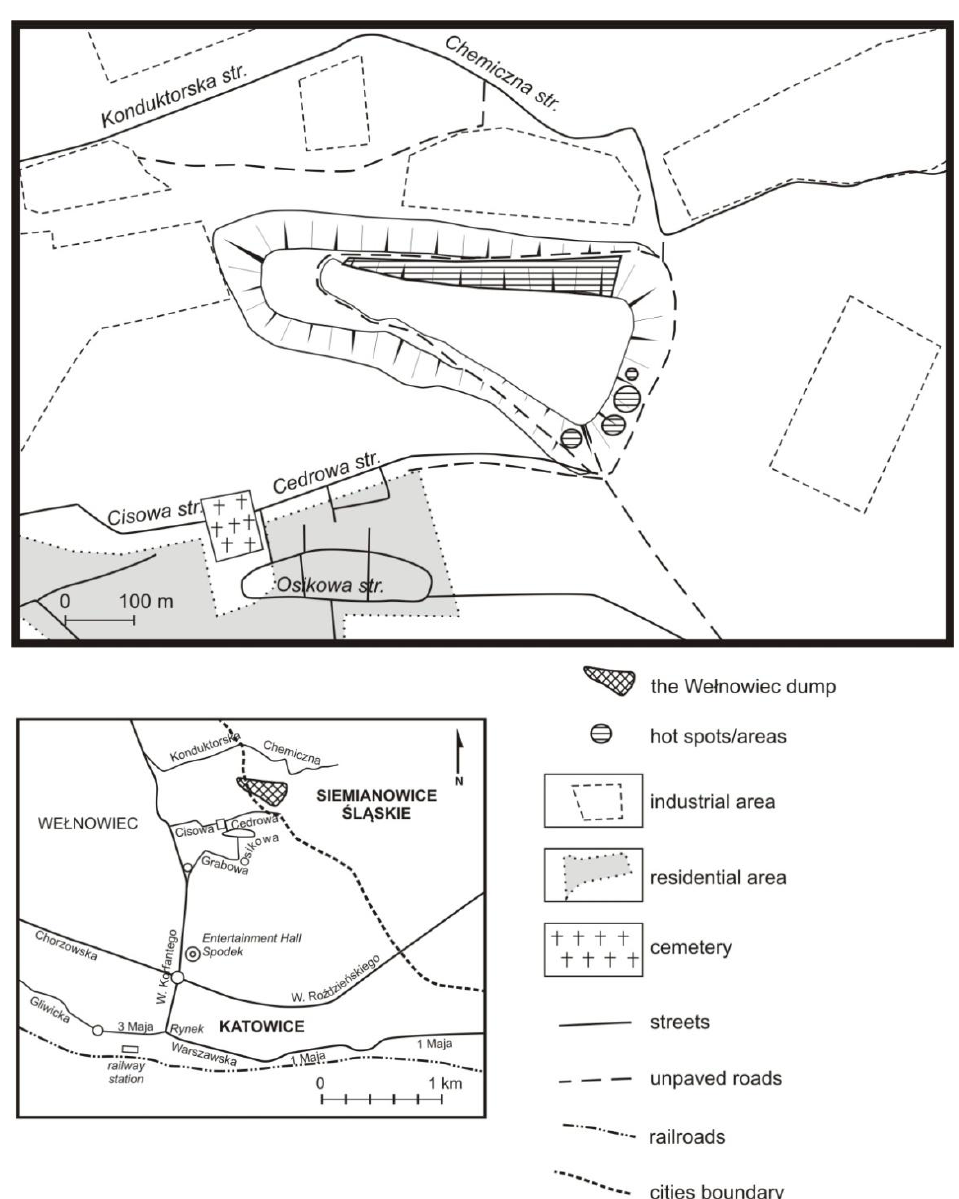
Fig. 1. Location of the Katowice-Wełnowiec municipal waste dump remediated with coal wastes. Thermally active areas are